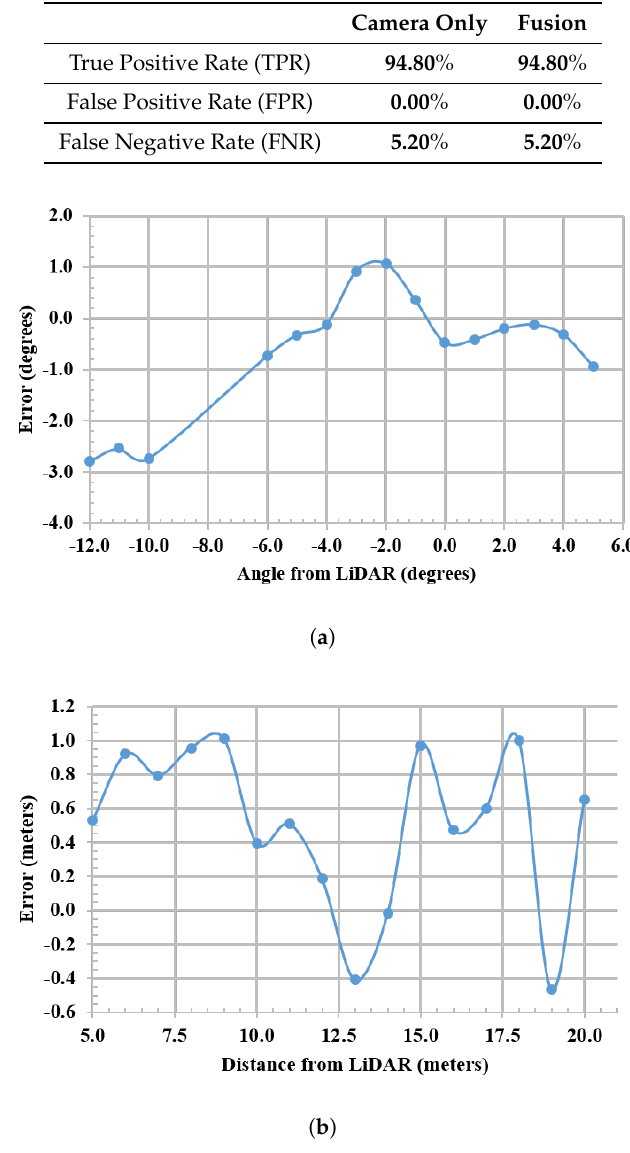
Figure 25. ( a ) Angle error of the camera. ( b ) Distance error of the camera. Camera